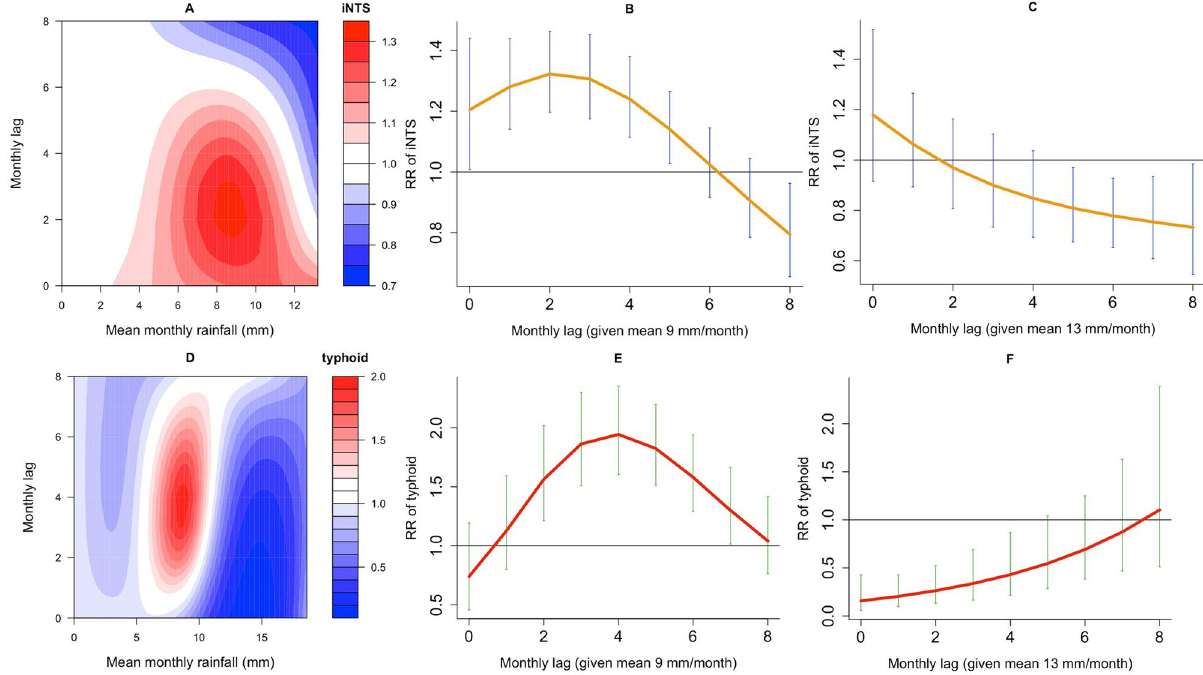
Figure 4. Relative risk (RR) of invasive Salmonella diseases given rainfall exposures and monthly lags. Contour plot of rainfall-lag-nontyphoid (iNTS) ( A ) relative to baseline mean monthly rainfall conditions of 0 mm at lags between 0 and 8 months, and lag-iNTS curve plots at 9 mm ( B ) and 13 mm ( C ) of rainfall with 95% Confidence Intervals; Contour plot of rainfall-lag-typhoid ( D ) relative to baseline mean monthly rainfall conditions of 0 mm at lags between 0 and 8 months, and lag-typhoid curve plots at 9 mm ( E ) and 13 mm ( F ) of rainfall with 95% Confidence Intervals.